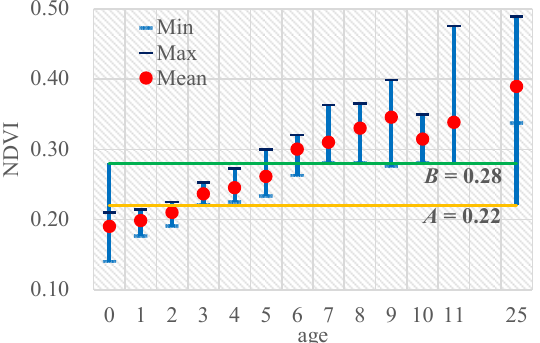
Figure 3. NDVI values of farmland shelterbelts with differing ages in 2020.